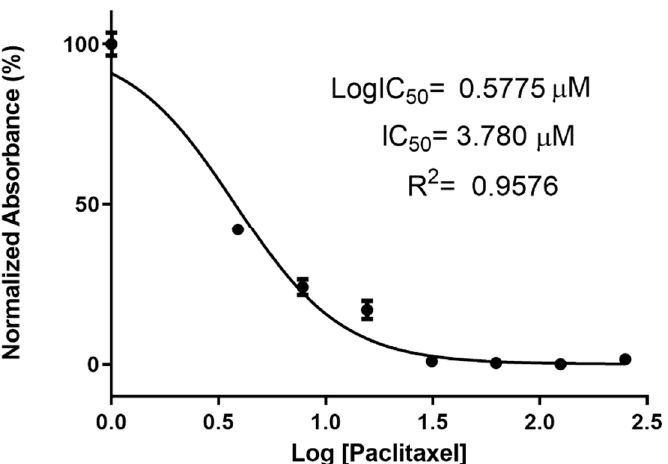
Figure 1. The half maximal inhibitory concentration (IC 50 ) value of paclitaxel solution on 4T1 murine breast cancer cell line at 48 h. Cells were treated with the different concentrations of Paclitaxel (250, 125, 62,5, 31.25, 15.6, 7.8, and 3.9 µ M). The absorbance was determined as a result (n = 6, mean ± SD).